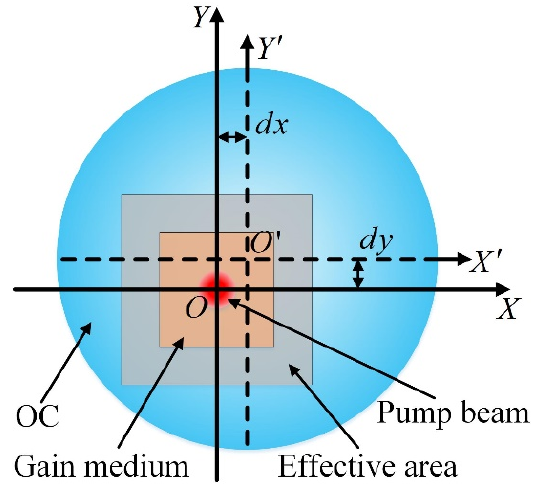
Figure 7. Schematic diagram of the off-axis OC